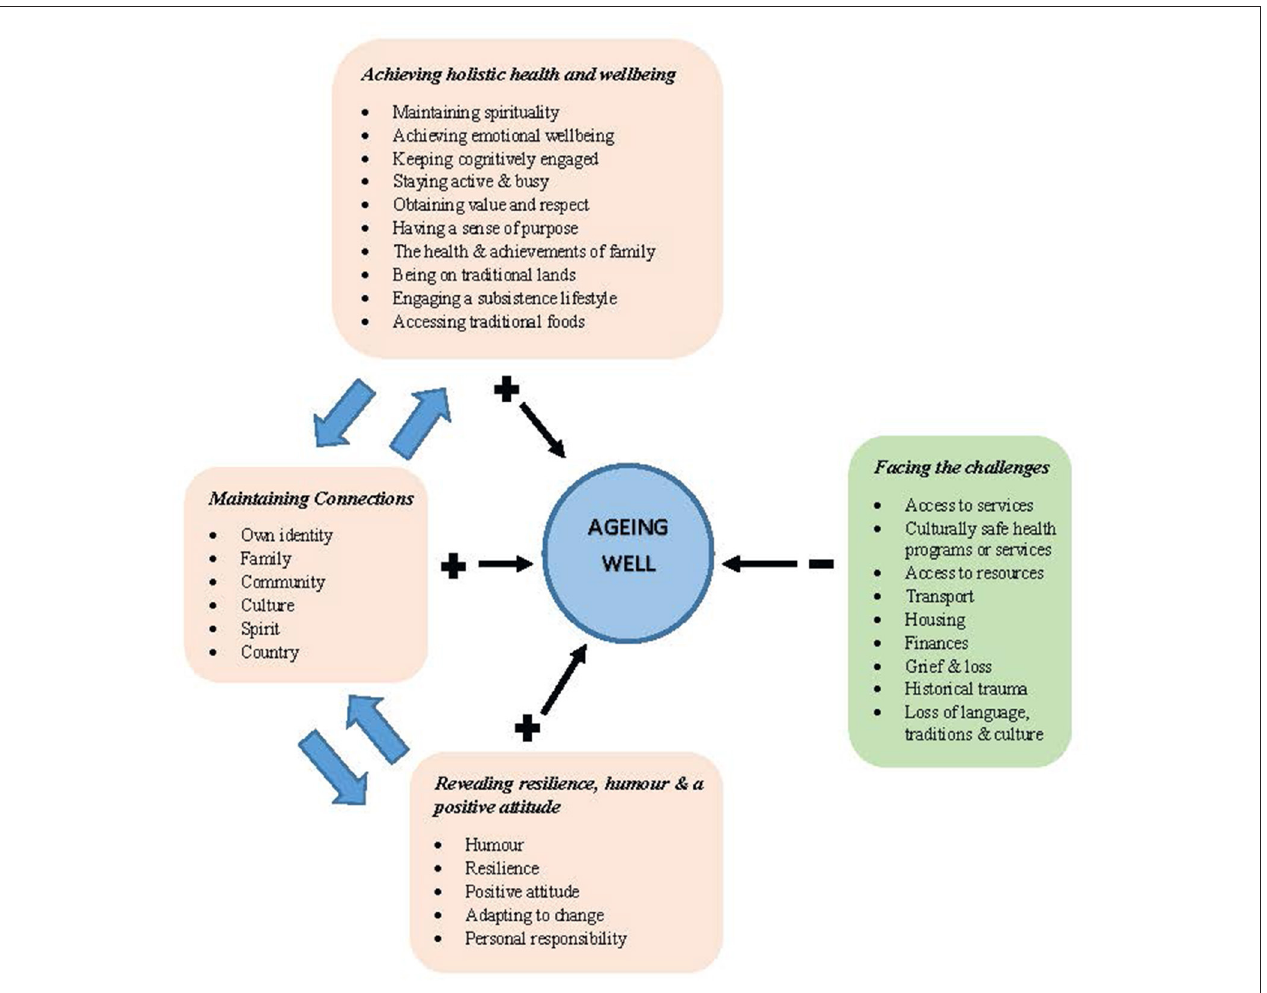
FIGURE 2 | Concept of ageing well as described in the scoping